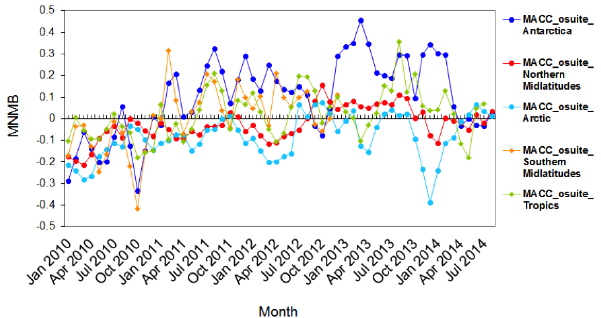
Figure 4. MNMB of ozone in the free troposphere (750–200hPa in the tropics and 750–300hPa elsewhere) of MACC o-suite against aggregated sonde data in four different